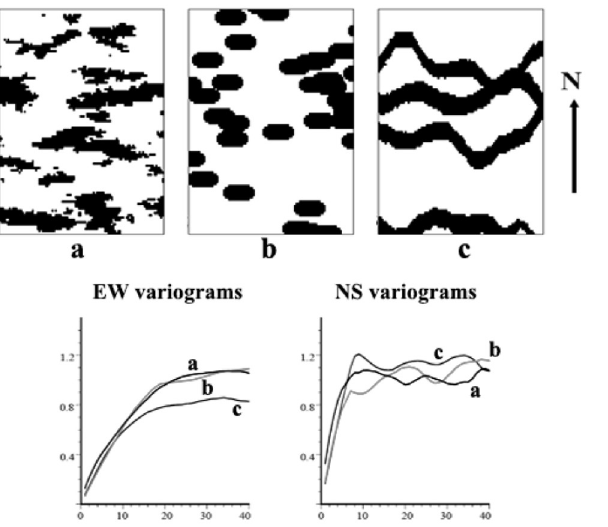
Fig 1. Variation functions of different spatial structures